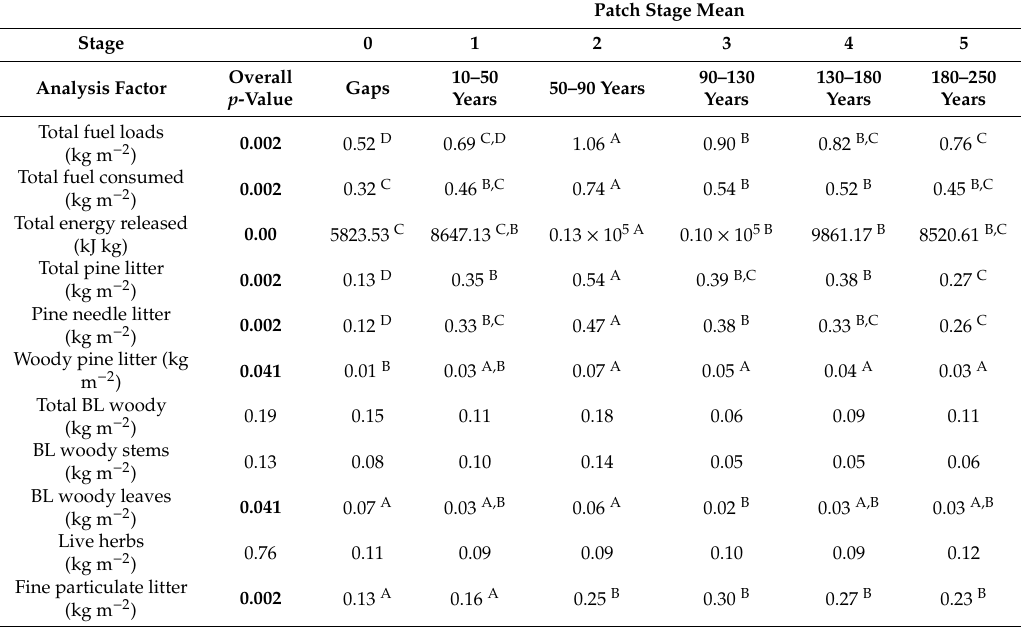
Table A3. Mean values of di ff erent fire fuel load attributes (BL = broadleaf) in each of the six patch stages and overall stage e ff ect p -value from PerMANOVA analyses. Bold p -values indicate significant results ( p < 0.05) and shared letter subscripts denote insignificant di ff erences indicated by PerMANOVA pairwise